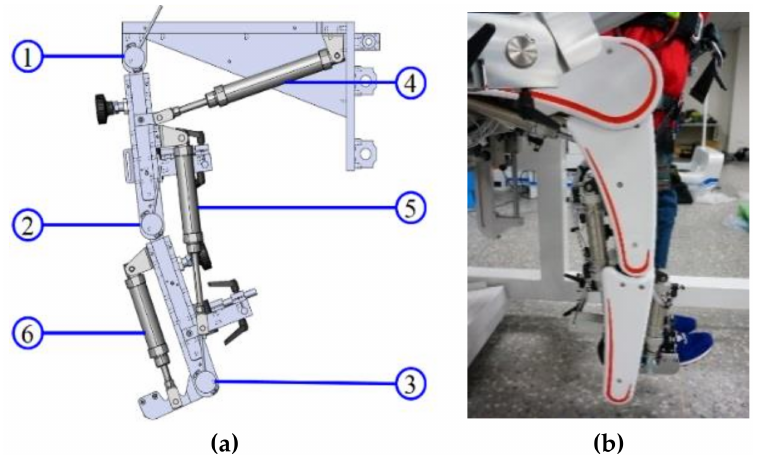
Figure 5. ( a ) The design of the PGOS; ( b ) picture of the PGOS. 1 (cid:13) Hip joint encoder, 2 (cid:13) Knee joint encoder, 3 (cid:13) Ankle joint encoder, 4 (cid:13) Hip joint pneumatic cylinder, 5 (cid:13) Knee joint pneumatic